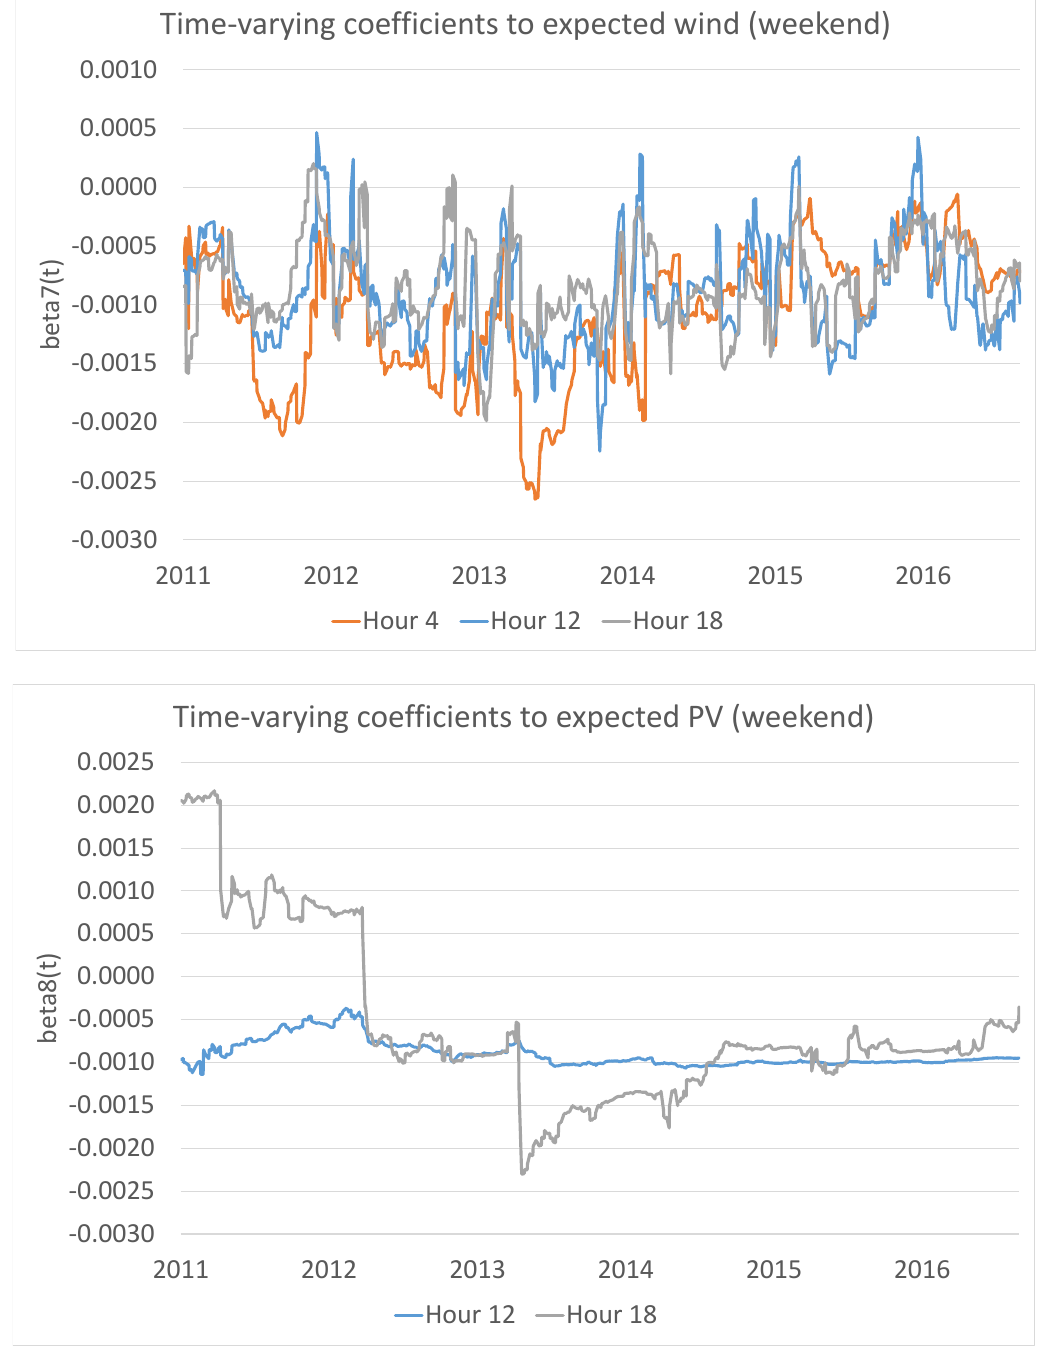
Figure 14. Time-varying coefficients of German wind and PV infeed. The coefficients have been estimated for the sample period from 1 January 2011 until 31 August 2016 with respect to the key hours H4, H12 and H18 on weekend